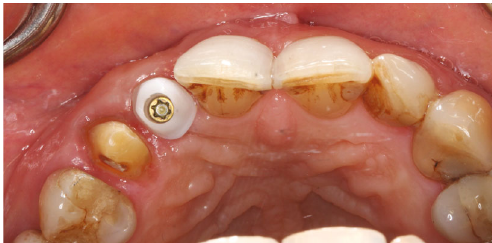
Figure 16: Custom-made implant abutment made of zirconium dioxide (Straumann CARES CAD/CAM).